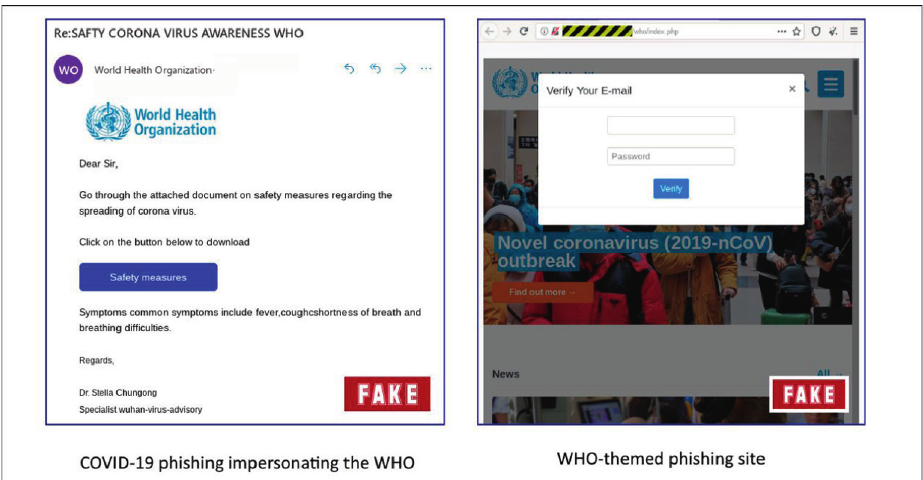
Figure 12: A well-known international health organization-themed phishing page [48].